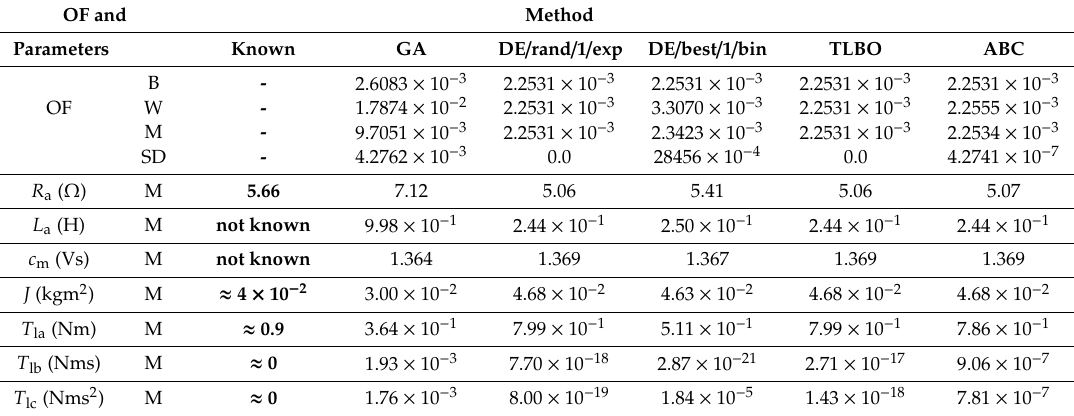
Table 10. OF and Mean value of the calculated parameters for 50 independent runs using RK for MD1. OF and Method